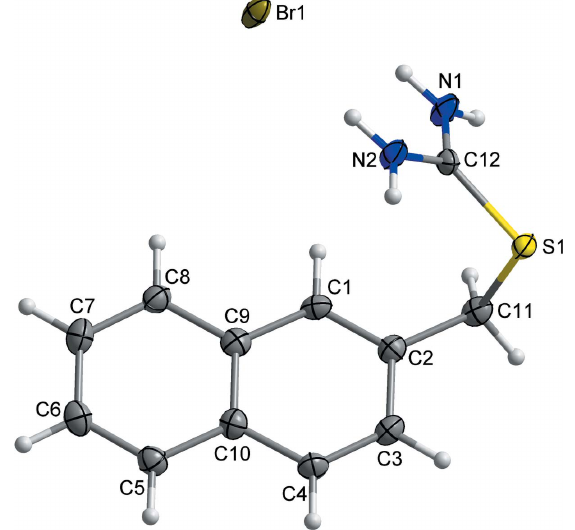
Figure 1 The title compound showing the numbering scheme with displacement ellipsoids drawn at the 50% probability level. H atoms are shown as spheres of arbitrary